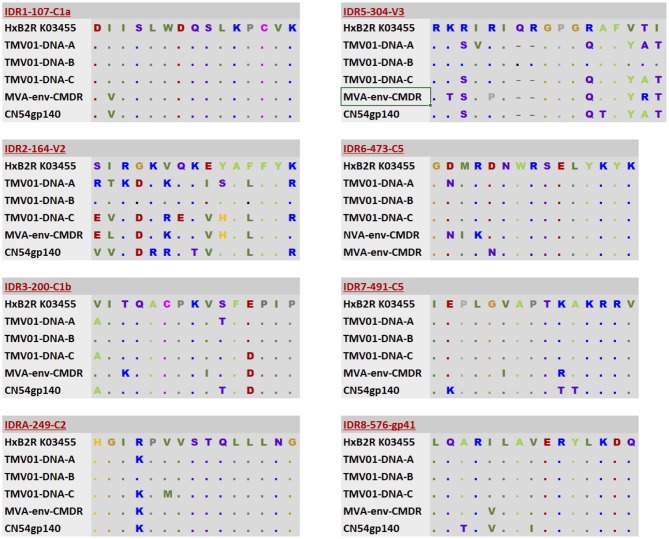
Alignment of immunogen sequences for the eight selected immunodominant antigenic regions for immunogens included in TMV01 and UK003SG. From top to bottom; the first row indicates the Immunodominant region, HxB2 location and Region name and shows a representative sequence for this region. Row 2–4 show three sequence variants of the TMV01-DNA encoded Env proteins representing subtypes A, B, and C, respectively. Row 5 shows the MVA-CMDR-gp150 encoded subtype E sequence that was used during TMV01. Row 6 shows the CN54 sequence, which matches the DNA and MVA-C-gp120 encoded Env immunogens of UK003SG and the CN54gp140 recombinant protein administered in both trials.